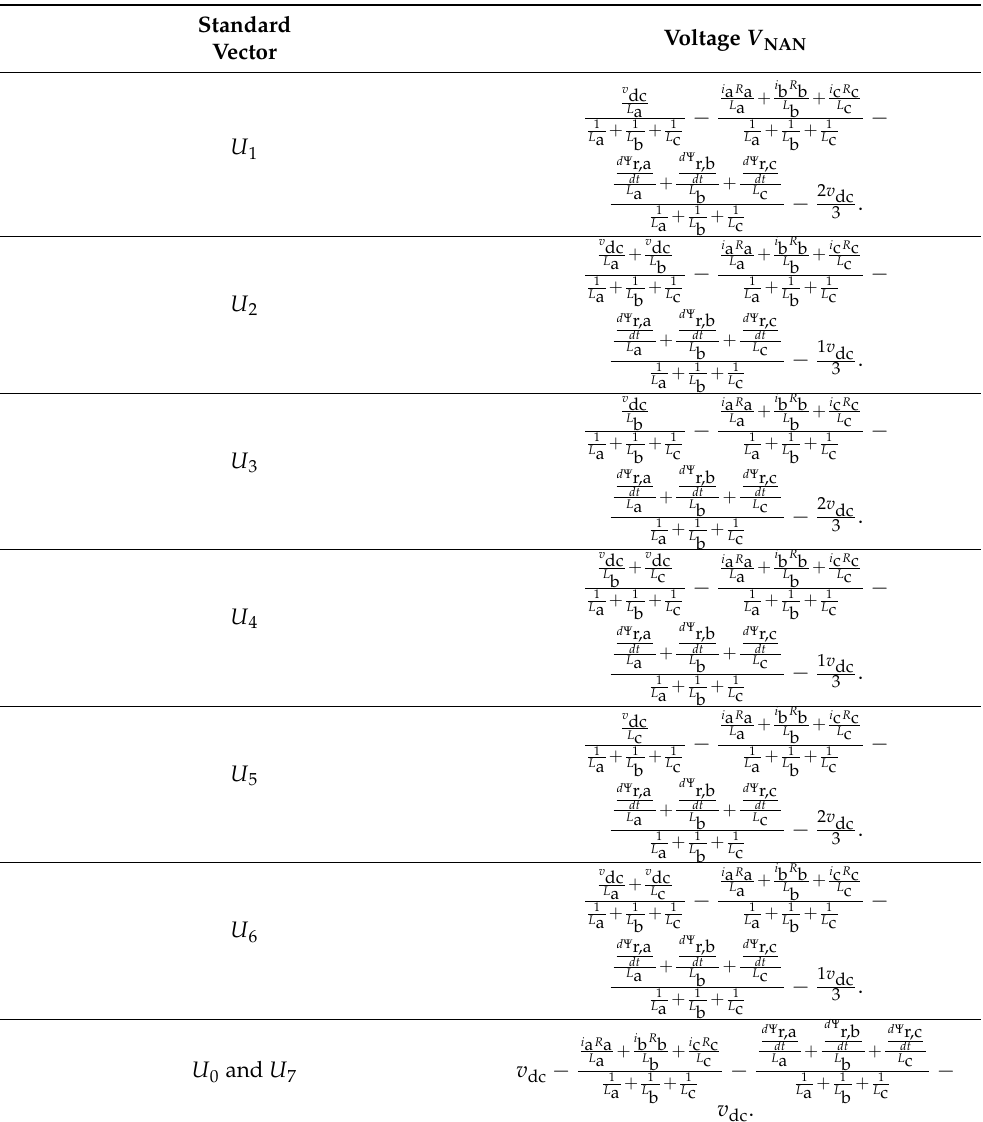
Table 1. Voltage between the star points at different standard space